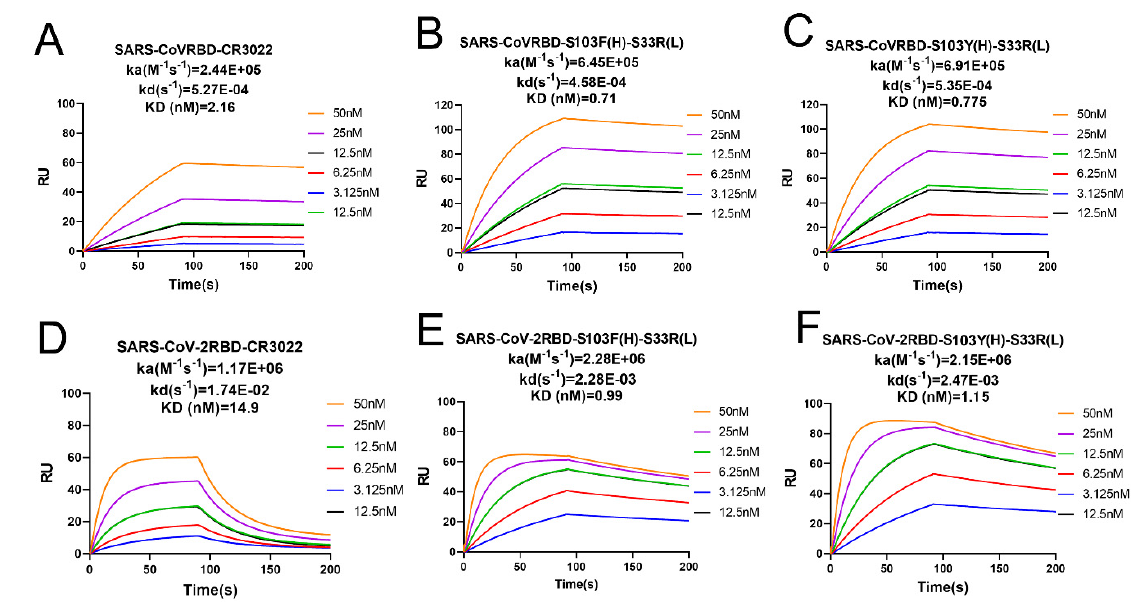
Figure 4. The binding kinetics and rate constants of SARS-CoV RBD and SARS-CoV-2 RBD to the wild-type CR3022 and its double-site mutation antibodies measured by surface plasmon resonance (SPR). SARS-CoV RBD-CR3022 ( A ), SARS-CoV RBD-S103F(H)–S33R(L) ( B ), SARS-CoV RBD-S103Y(H)–S33R(L) ( C ) and SARS-CoV-2 RBD-CR3022 ( D ), SARS-CoV-2 RBD-S103F(H)–S33R(L) ( E ) and SARS-CoV-2 RBD-S103Y(H)–S33R(L) ( F ) are the binding curves with decreasing concentrations of the indicated antibodies injected over the antibody captured by anti-Fc tag antibody immobilized on an SPR chip. Values of kinetic rate constants (KD(nM)) were indicated for each antibody on top of the individual plots.